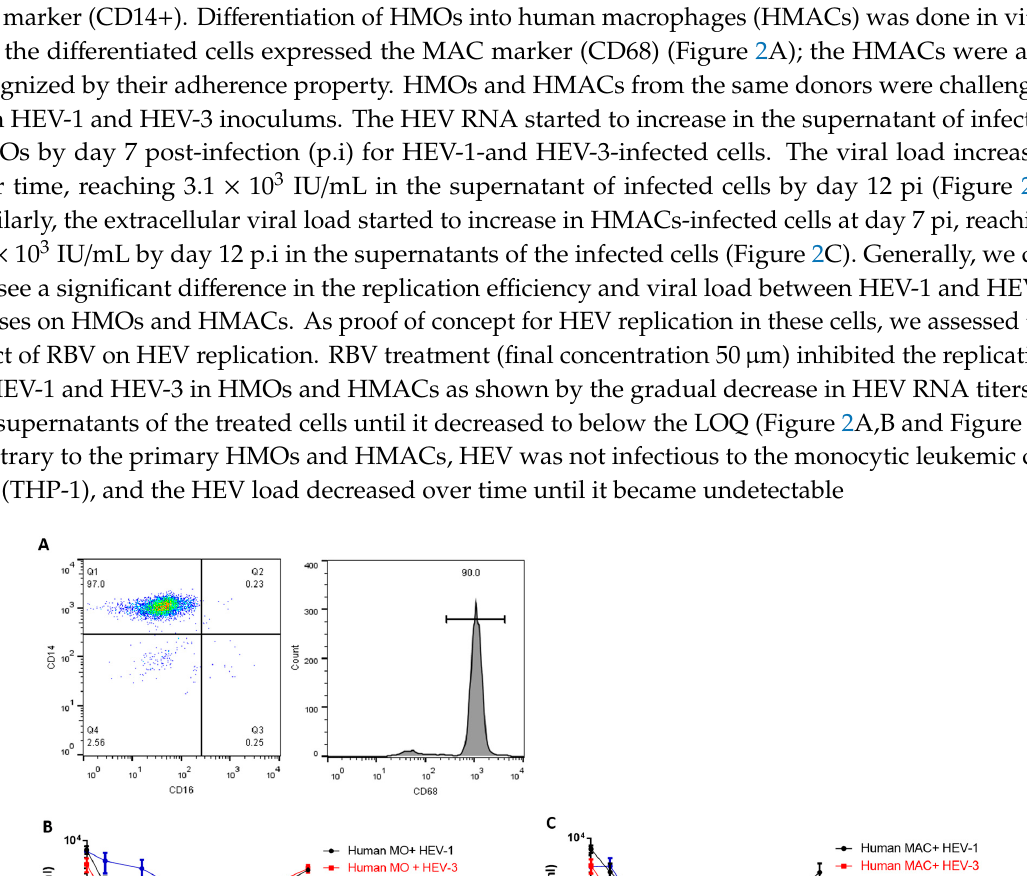
values of three independent experiments ±